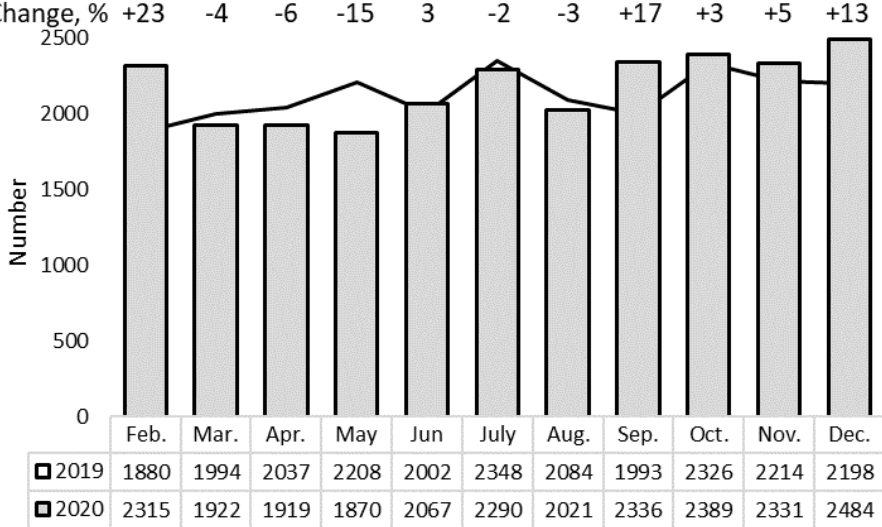
Figure 1. Monthly distribution of systemic anticancer therapy procedures in out-patient and in-patient units.